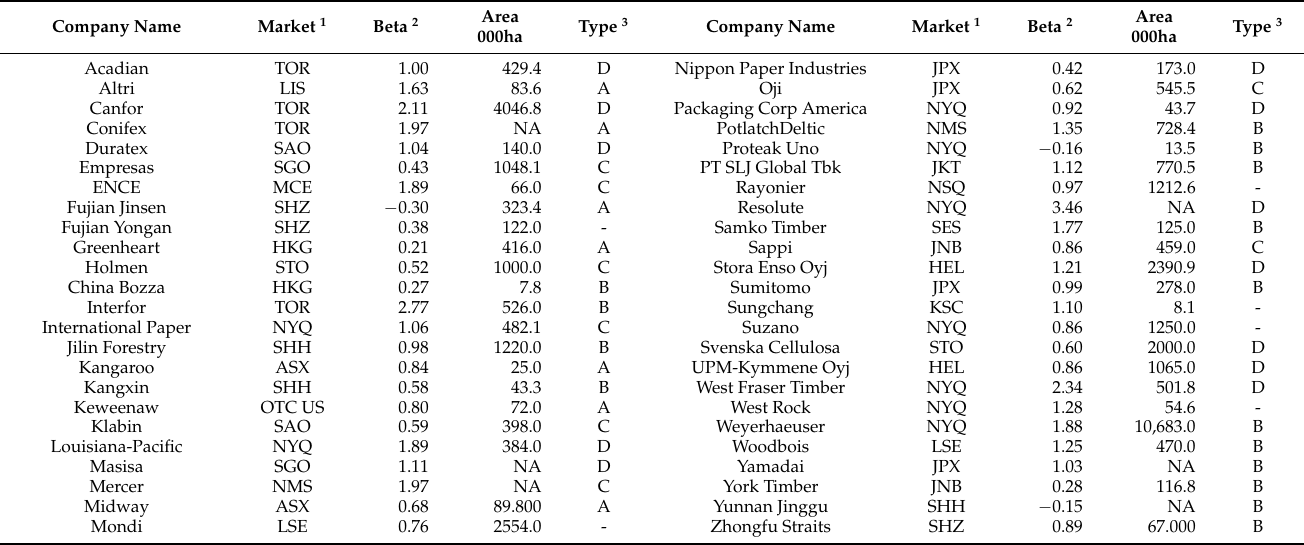
Table 2. List of publicly traded forestry